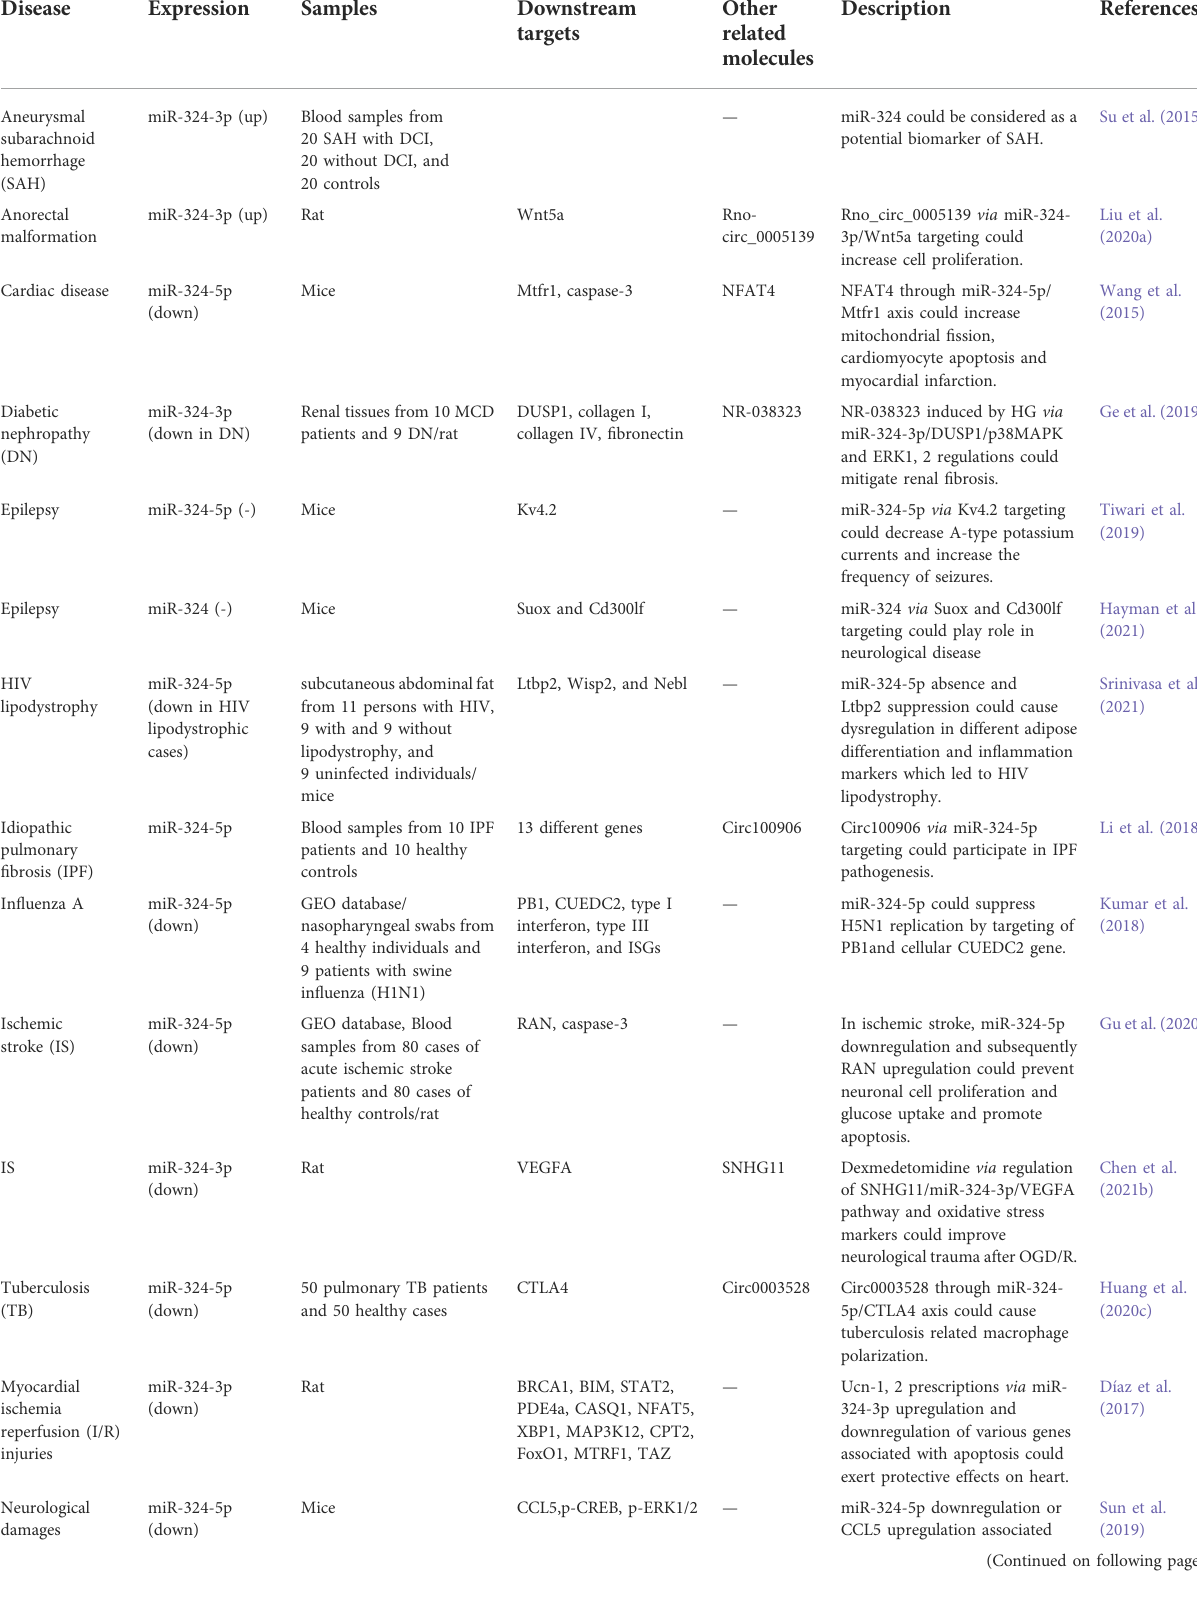
TABLE 3 miR-324 in non-malignant diseases (DCI,Delayed cerebralinfarction; IEC, intestinal epithelial cells; MCD, minimal change disease;HG, high glucose; Ucn, Urocortin; OGD/R, oxygen-glucose deprivation/reoxygenation; NOF, neck of the femur; EX, aerobic exercise; SED,